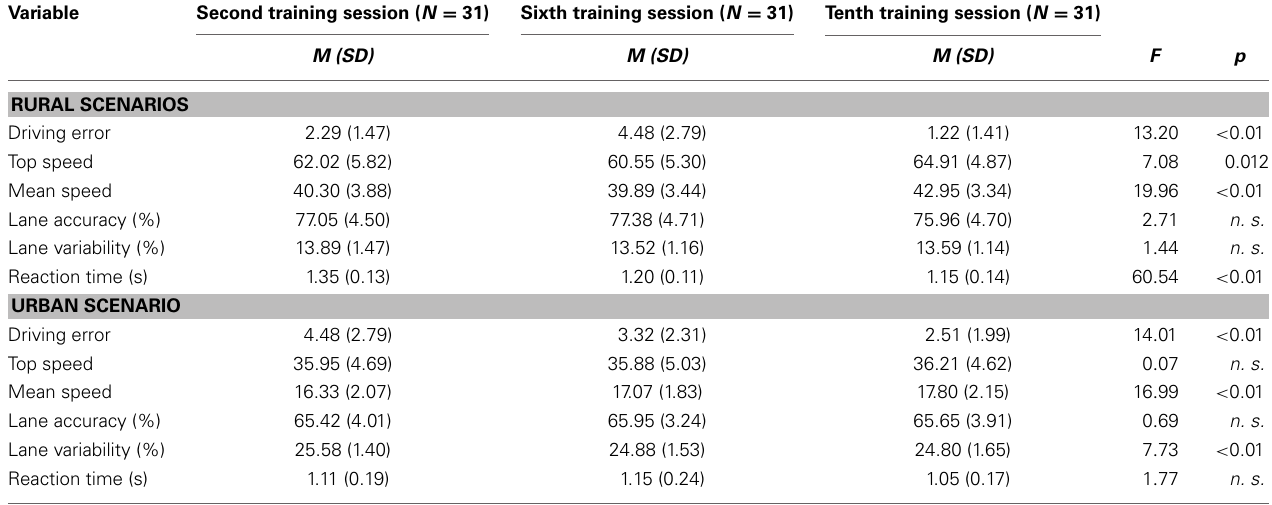
Table 4 | Training progress: simulator